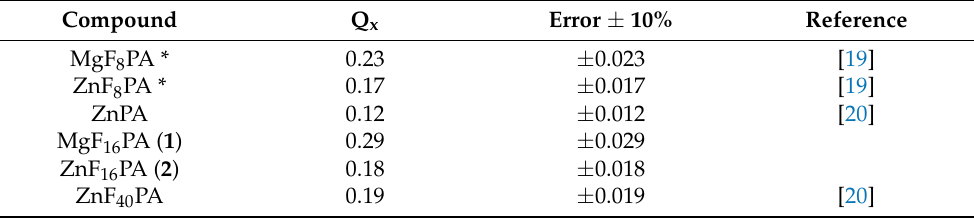
Table 2. Quantum yields of fluorescence of magnesium and zinc octaaryltetraazaporphyrins com- plexes containing a different number of fluorine atoms in tetrahydrofuran. Compound Q x Error ± 10% Reference MgF 8 PA